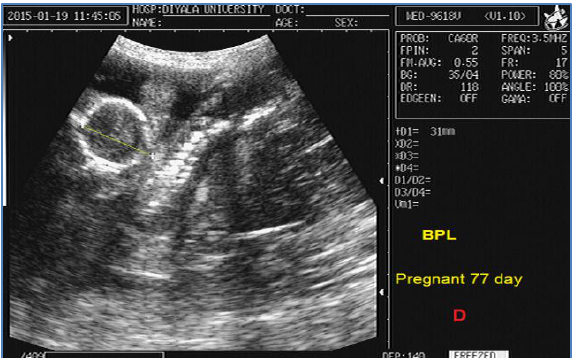
Figure, 8: Measurement of fetal BPD in 11 th week of pregnancy, indicated by straight line (Sector probe, 3.5MHz).